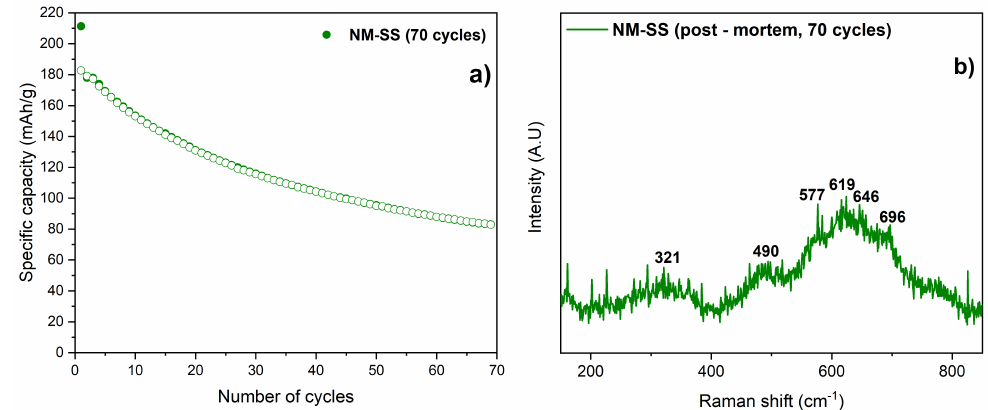
Figure 9. ( a ) Performance of NM-SS during 70 charge/discharge cycles. ( b ) Post mortem Raman spectra of the electrode made from NM-SS after 70 charge/discharge